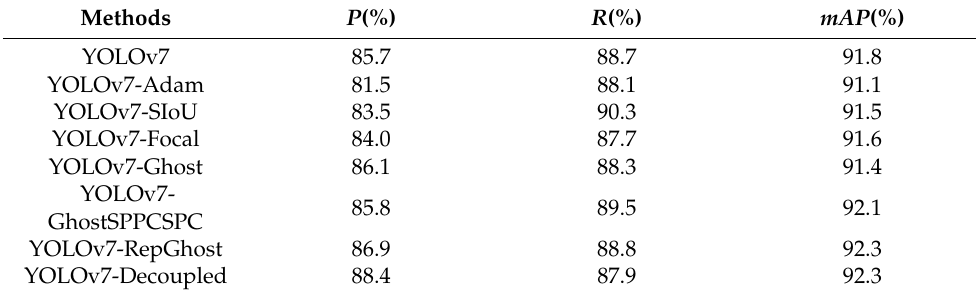
Table 5. The hyperparameters in the training process.